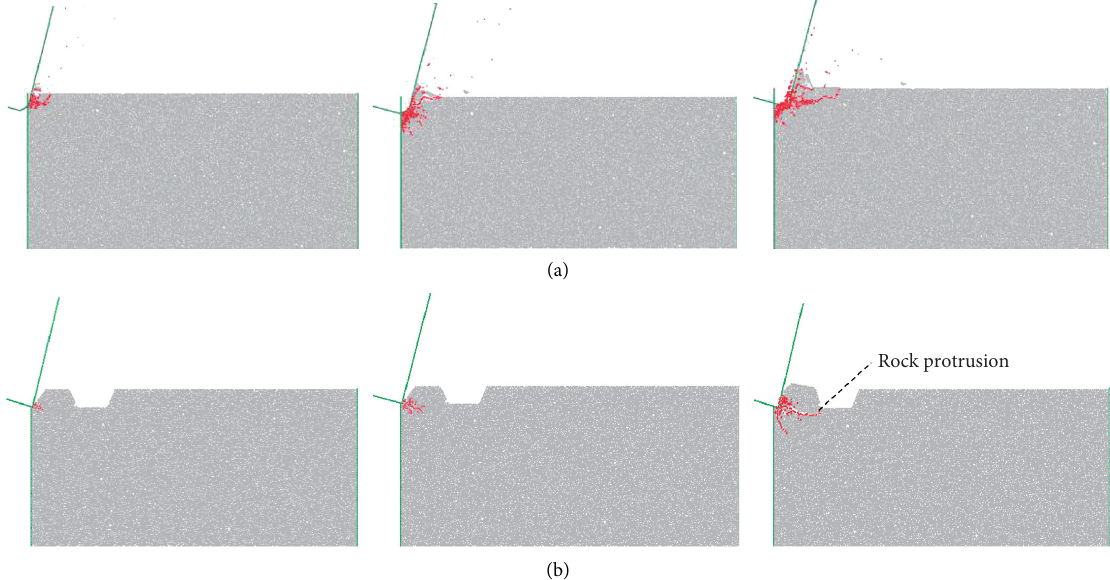
Figure 8: Crack propagation of rock under different cutting modes. (a) Unidirectional cutting and (b) cross-cutting.